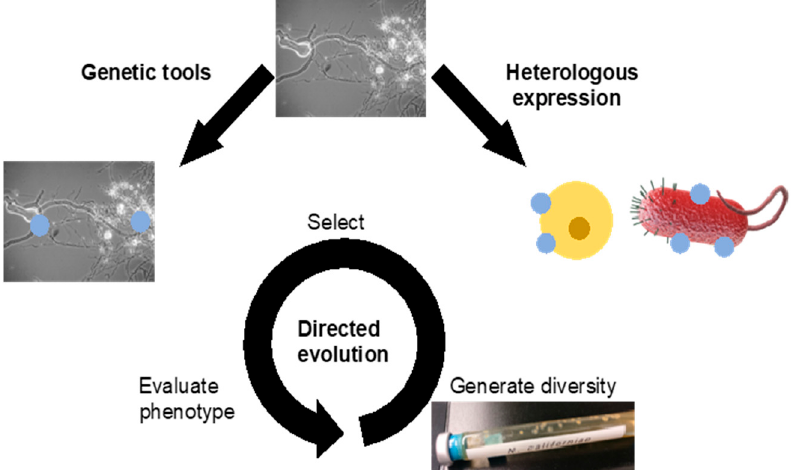
Figure 3. Anaerobic fungi show great potential for new genetic tool development and heterologous expression for biofuels production. Blue dots represent inserted or modified proteins, e.g., a fluorescent reporter attached to a knock-in cellulase. Fungi or heterologous hosts can be evolved for improved phenotypes, such as H 2 production.